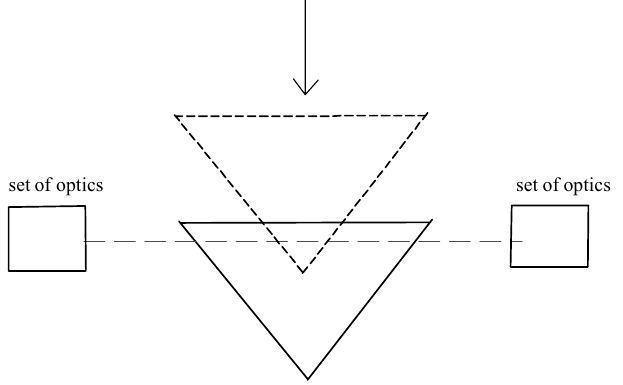
Figure 2. Schematic diagram of, with top view prism refractometer using laser displacement interferometer and translation stage.